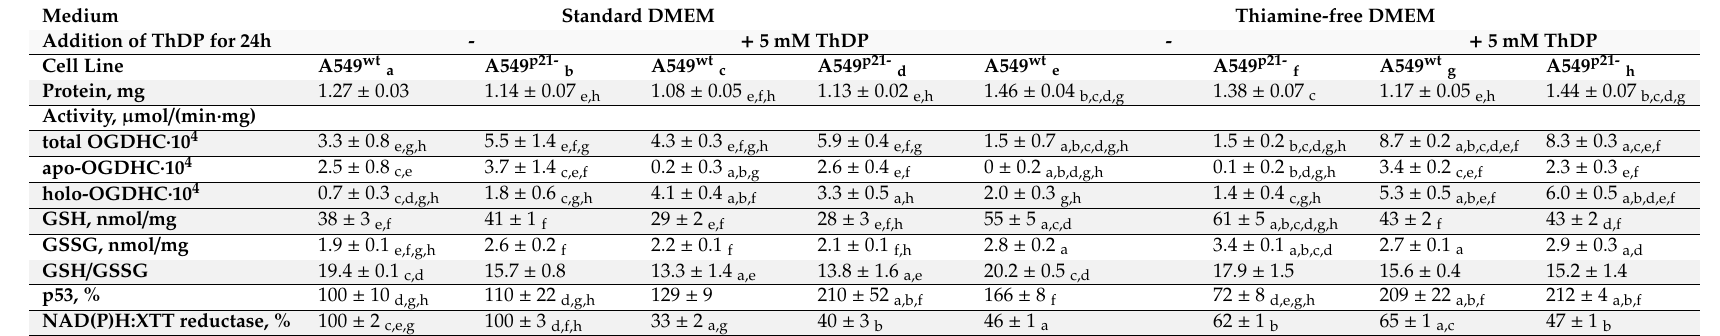
Table 1. E ff ect of 24 h incubation with 5 mM ThDP on the assayed metabolic parameters of A549 wt and A549 p21- cells in the standard or thiamine-free DMEM. The data of at least three independent experiments are presented as means ± SEM. The eight experimental groups are marked by the letters (a–h) in the “Cell line” row. Statistically significant di ff erences ( p < 0.05) are determined by two-way ANOVA followed by Tukey’s post hoc test and are indicated as the di ff erence of considered parameter to that in the corresponding experimental groups (a–h). Because the reaction rates of cellular NAD(P)H:XTT reductase are relative to the corresponding control cells, the comparison of this parameter is done only for di ff erent conditions applied to either A549 wt or A549 p21- cells. GSH—glutathione, GSSG—glutathione